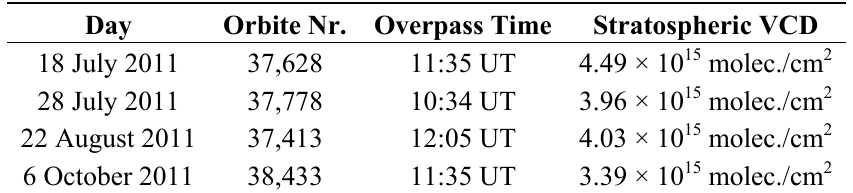
Table 2. Information on the OMI data used in this work.